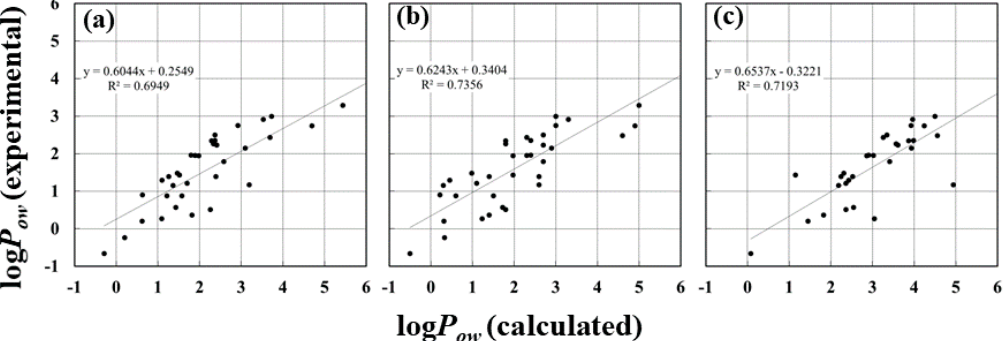
Figure 7. Scatter diagrams of calculated using ( a ) GAFF, ( b ) GAFF-DC, and ( c ) P logP { w , { v , o }}, and experimentally measured log P ow values for 32 compounds . The values calculated by GAFF and GAFF-DC, and the experimentally measured values were taken from the reference by Bannan et al. [45].